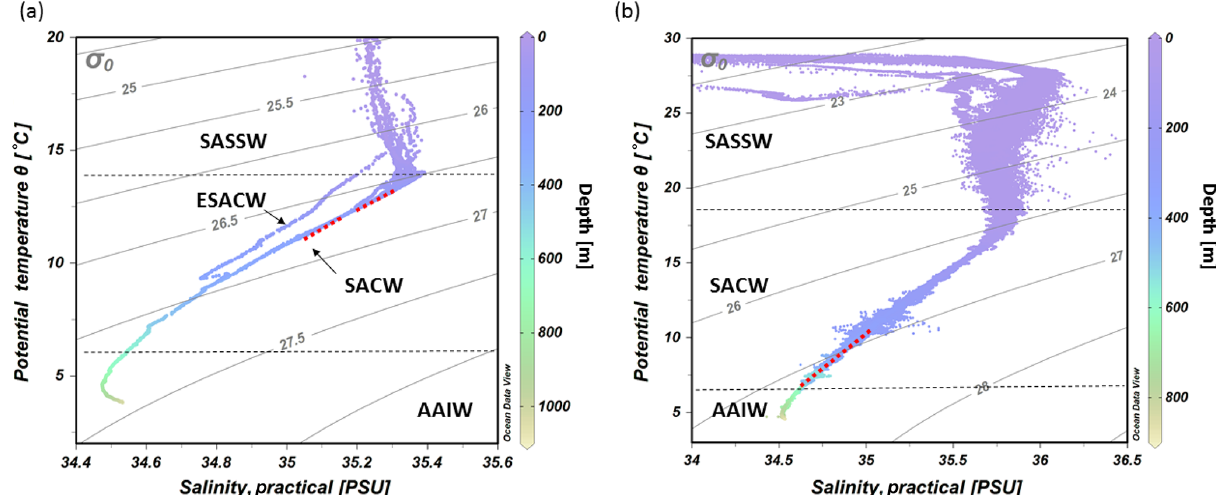
Figure 3. T – S diagrams showing the different water masses being present at the (a) Namibian and (b) Angolan margins: South Atlantic Subtropical Surface Water (SASSW), South Atlantic Central Water (SACW) and Eastern South Atlantic Central water (ESACW), Antarctic Intermediate Water (AAIW) (data plotted using Ocean Data View v.4.7.8; http://odv.awi.de, last access: 12 February 2016; Schlitzer, 2011). Red dotted line indicates the depth range of cold-water coral mound